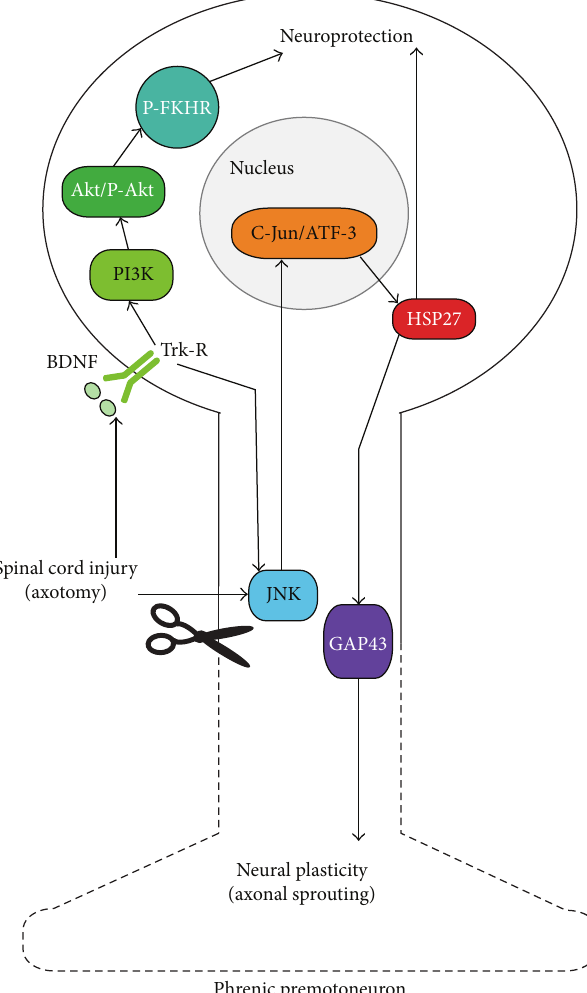
Figure 2: Diagram showing the induction of neuroprotection and neuroplasticity of phrenic premotoneurons after a cervical spinal cord injury. The injury-induced neuroplasticity through GAP43 expression involves JNK activation, c-Jun and ATF3 activation, and HSP27 induction. JNK can also be activated by tyrosine kinase receptor (Trk-R). The injury-induced neuroprotection involves BDNF increase, activation of TrK-R, activation of PI3K-Akt, and phosphorylation of FKHR. The pathway inducing HSP27 is also known to be involved in